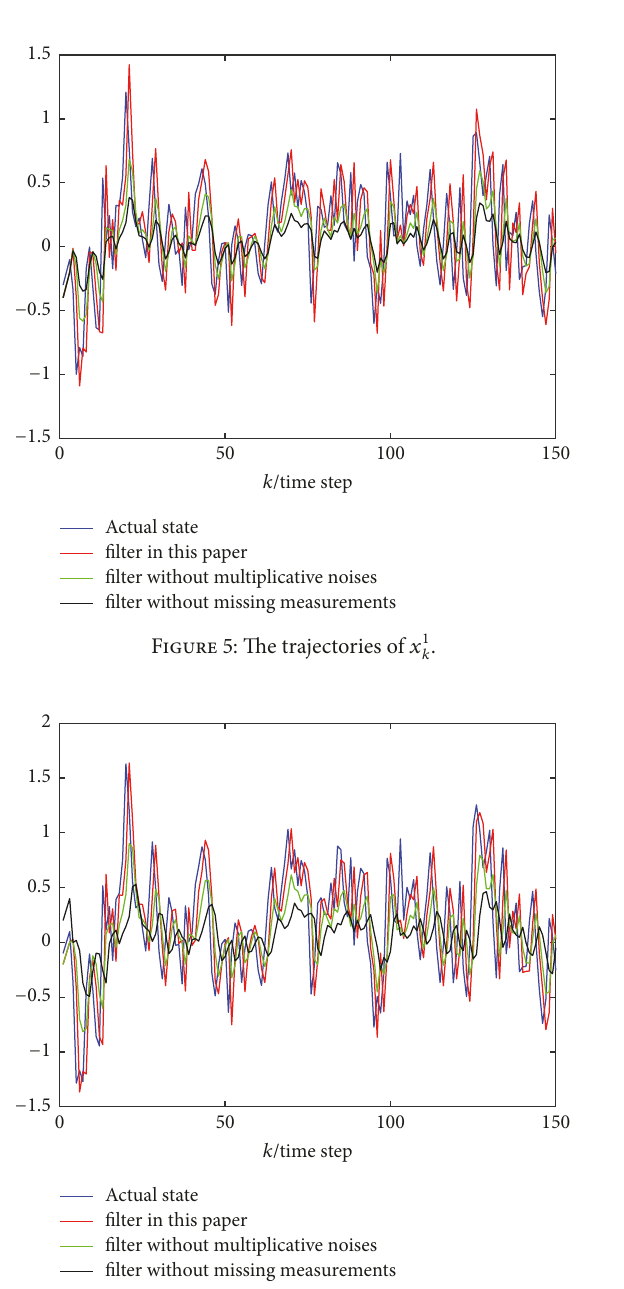
Figure 6: The trajectories of 𝑥 2 𝑘 .